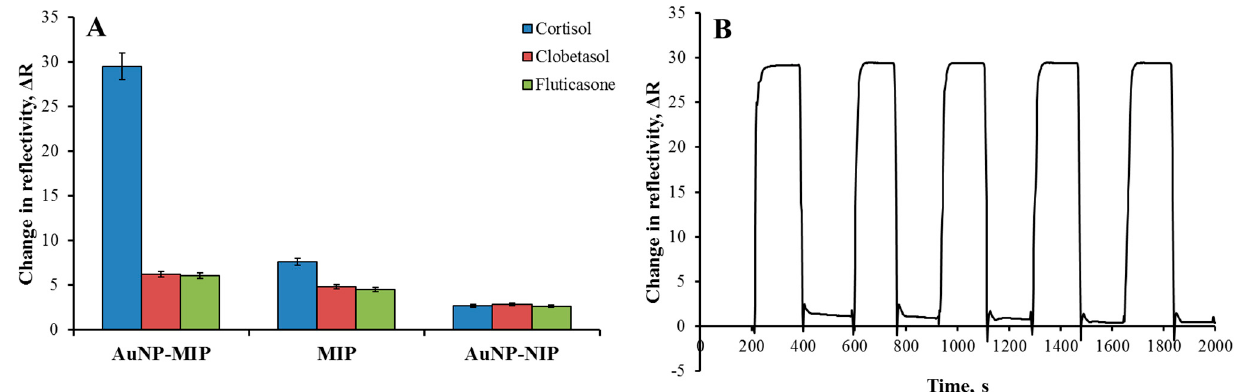
Figure 6. Selectivity comparison graph ( A ) and reusability sensograms ( B ) of AuNP-MIP plasmonic sensor. Cortisol concentration: 100 ppb; adsorption solution: PBS-ethyl alcohol (50:50, v / v ); flow rate: 0.2 mL/min; T: 25 °C.